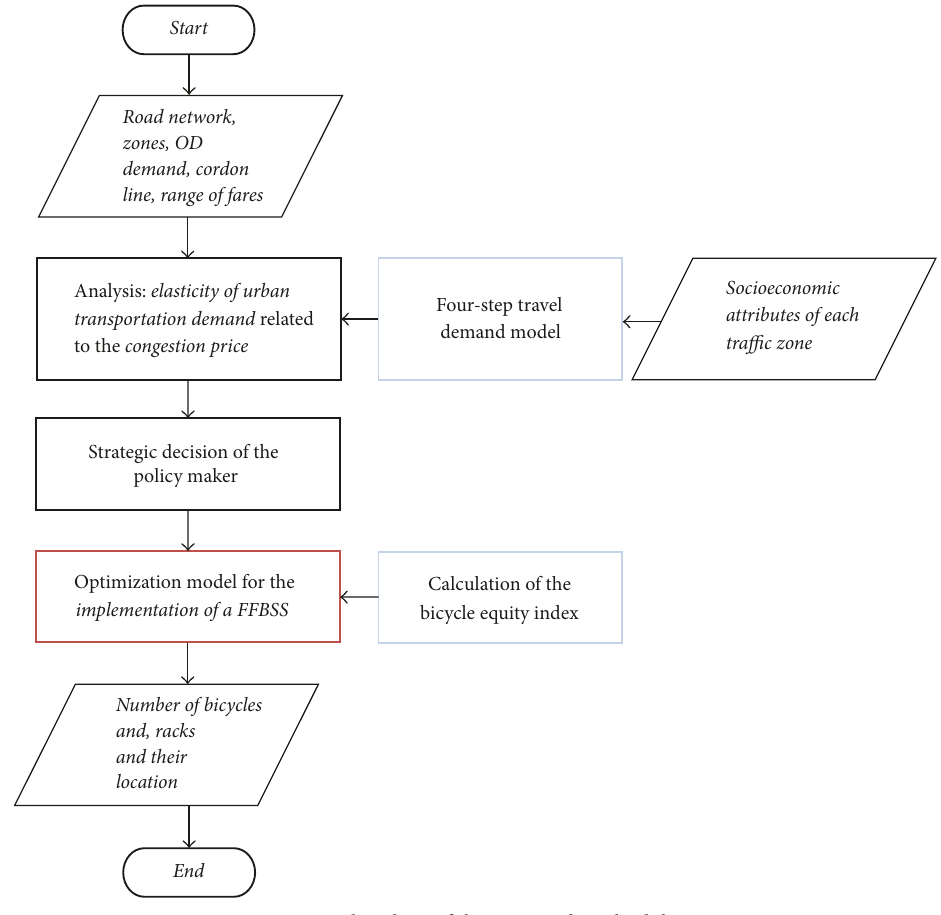
Figure 1: Flowchart of the proposed